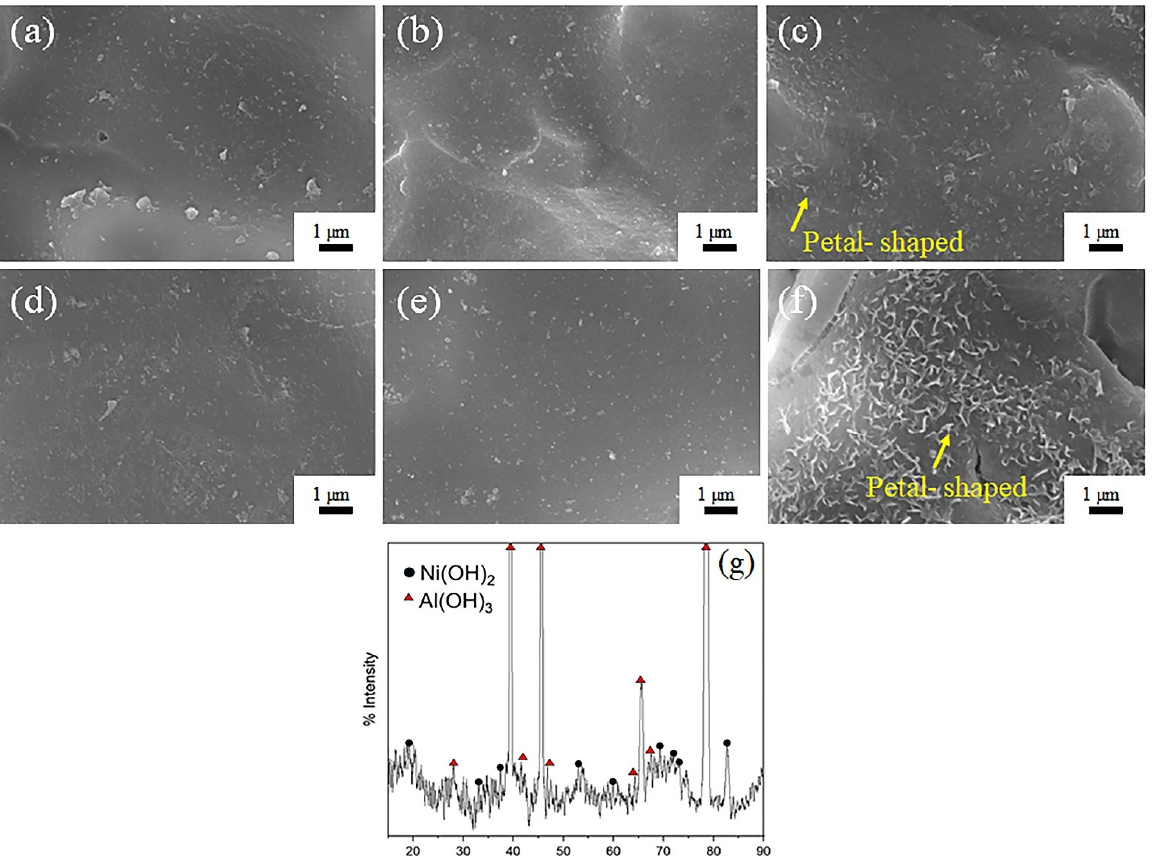
Figure 8. Magnified images of the anodized sample surface with each alkaline etching for ( a – c ) 2 min and ( d – f ) 4 min: ( a , d ) without sealing; ( b , e ) sealed with nickel fluoride and ( c , f ) sealed with stearic acid (SEM); and ( g ) XRD result of Al(OH) 3 and Ni(OH) 2 oxides of 4-N specimen.